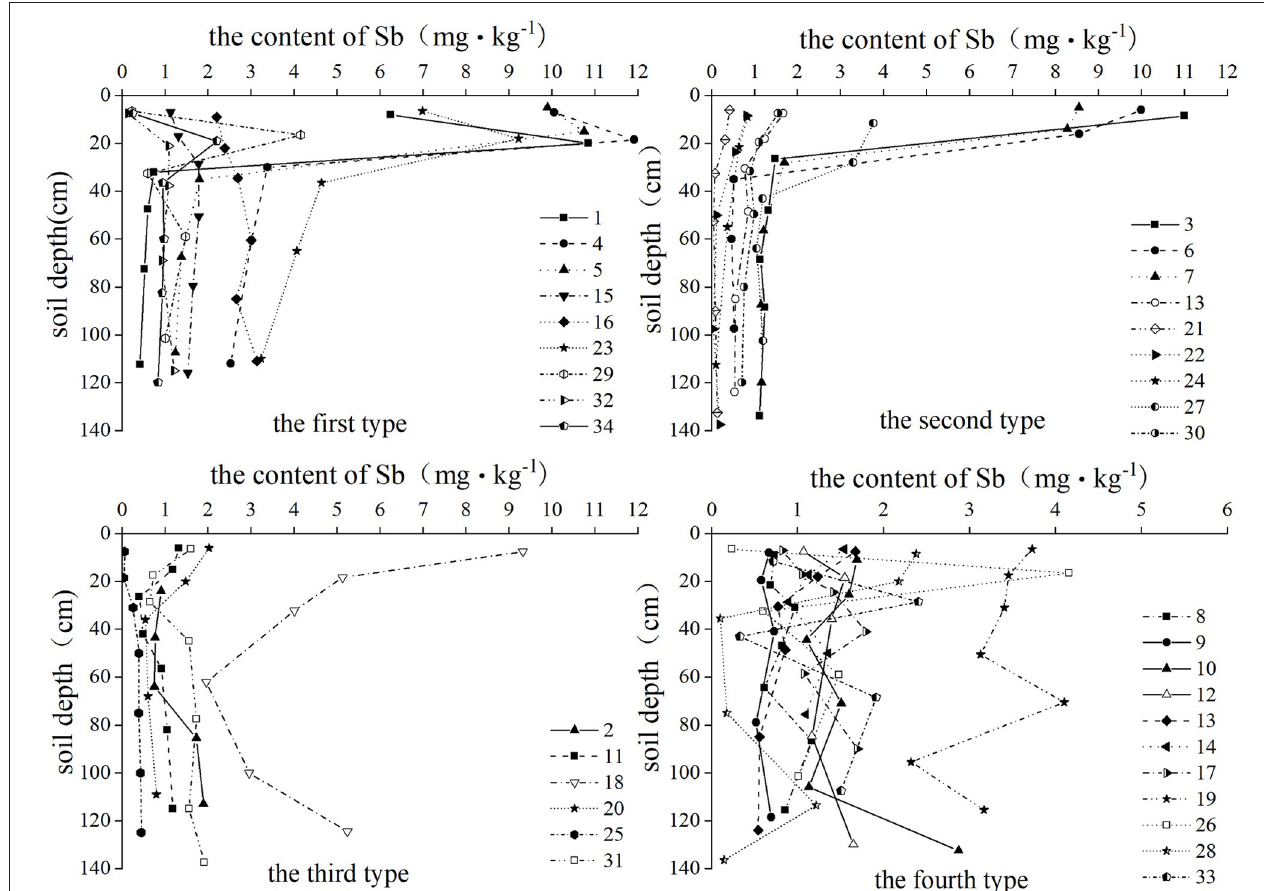
FIGURE 7 | The profile distribution characteristics of Sb in paddy